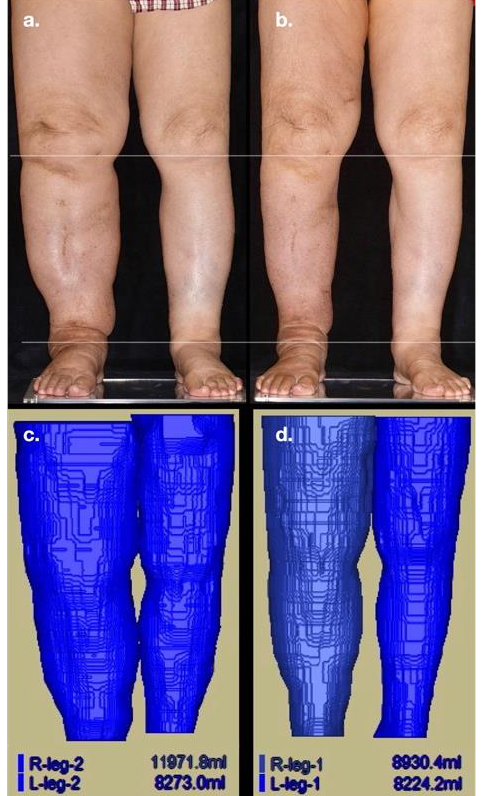
Figure 1. ( a ) An 81-year-old woman with a body mass index (BMI) of 27.4 kg/m 2 received a total hysterectomy with lymph node dissection followed by adjuvant radiotherapy for cervical cancer 19 years ago. Right lower-limb lymphedema was noted for 14 years with recurrent cellulitis (three times). ( b ) One-year follow-up after lymphaticovenous anastomosis (LVA) showing notable volume reduction in the affected limb after the performance of a total of nine LVAs. ( c ) Pre-LVA magnetic resonance (MR) volumetry demonstrating a right lower-limb volume of 11,971.8 mL and a left lower-limb volume of 8273.0 mL, with the volume gained in the affected limb due to lymphedema being +3698.8 mL (11,971.8 mL minus 8273.0 mL). ( d ) Post-LVA MR volumetry at one-year follow-up revealing a reduced right lower-limb volume of 8930.4 mL (minus 3041.4 mL) with the percentage volume reduction being 82.2% (3041.4 mL/3698.8 mL times